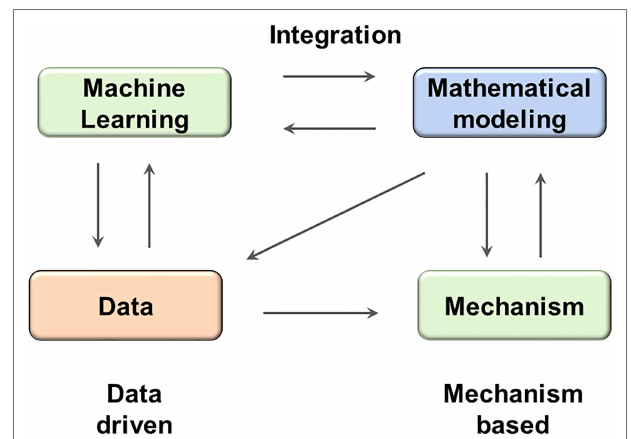
FIGURE 6 | The integration between machine learning and mathematical modeling might result in synergistic effect. ML methods can facilitate the analysis of both real data and simulated data generated by mathematical models; while mathematical models can test hypothesis provided by ML models and reveal mechanistic